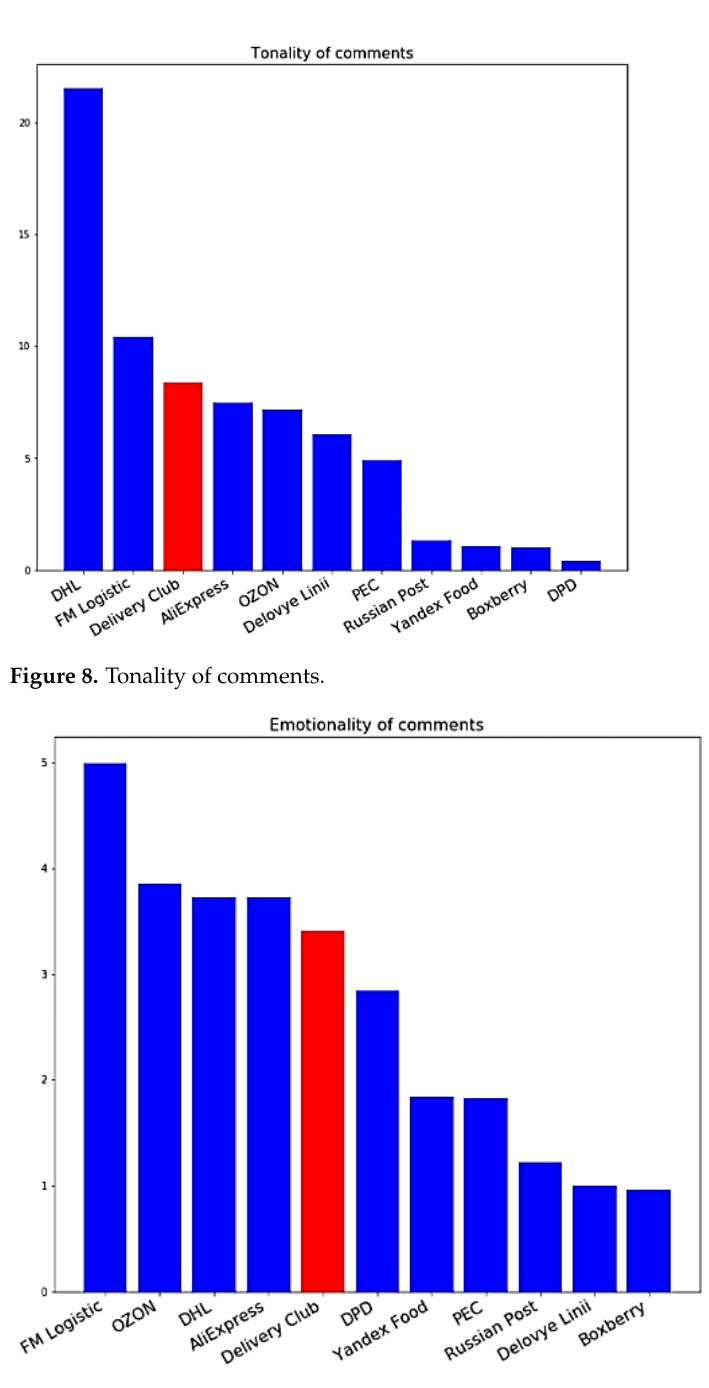
Figure 9. Emotionality of comments.